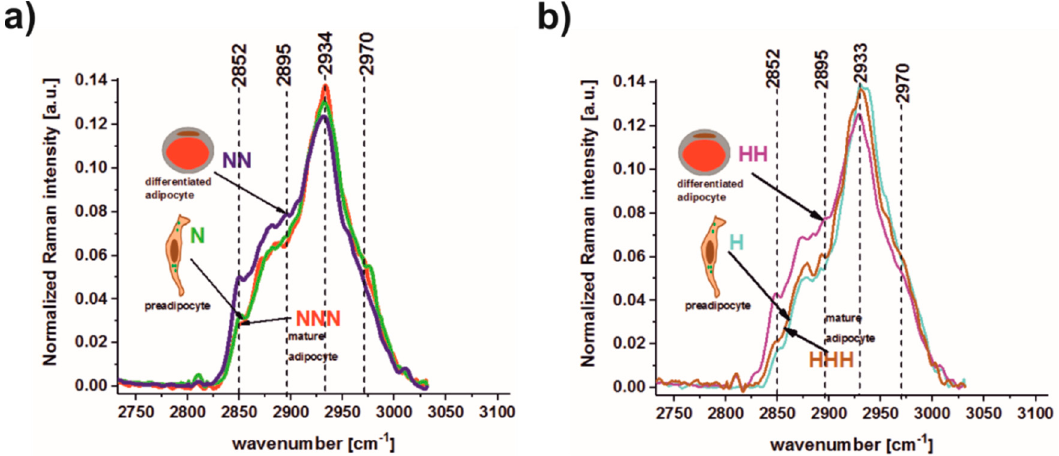
Figure 2. The average Raman spectra typical for the high-frequency region recorded for pAds, differentiated Ads and mature Ads under ( a ) normoglycemic (N, green line; NN, blue line; NNN, red line) and ( b ) hyperglycemic conditions (H, turquoise line; HH, purple line; HHH, brown line). Arrows are used to indicate which spectrum corresponds to a given type of adipocyte.